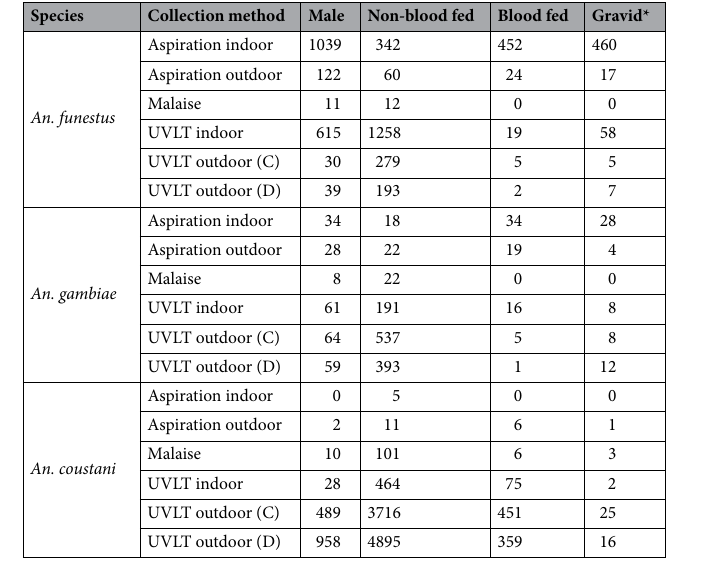
Table 1. The number of An. gambiae , An. funestus and An. coustani collected using different trapping methods and tested for sugar by cold anthrone test. *Includes both gravid and half gravid.